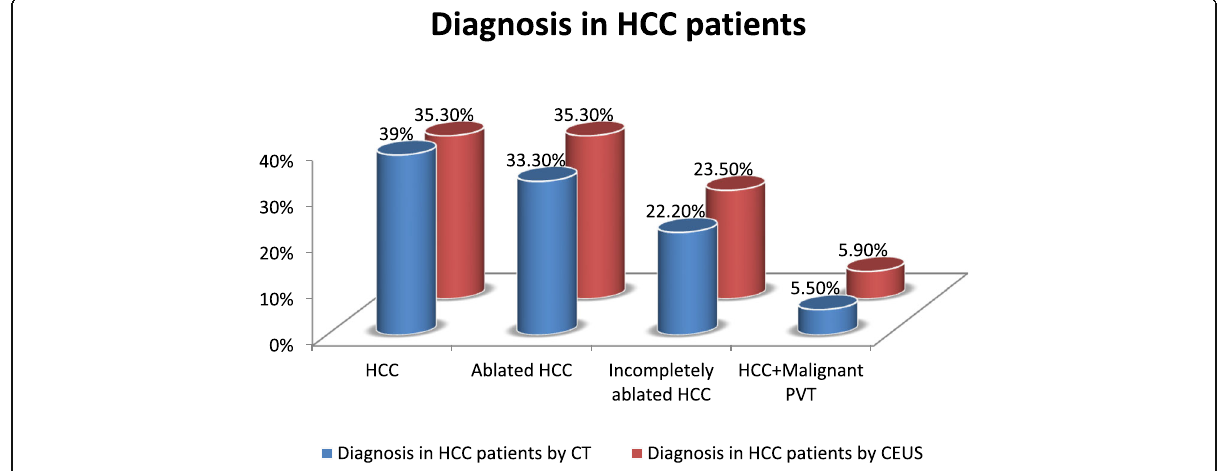
Fig. 1 Diagnosis and post-therapeutic assessment of HCCs by CT and